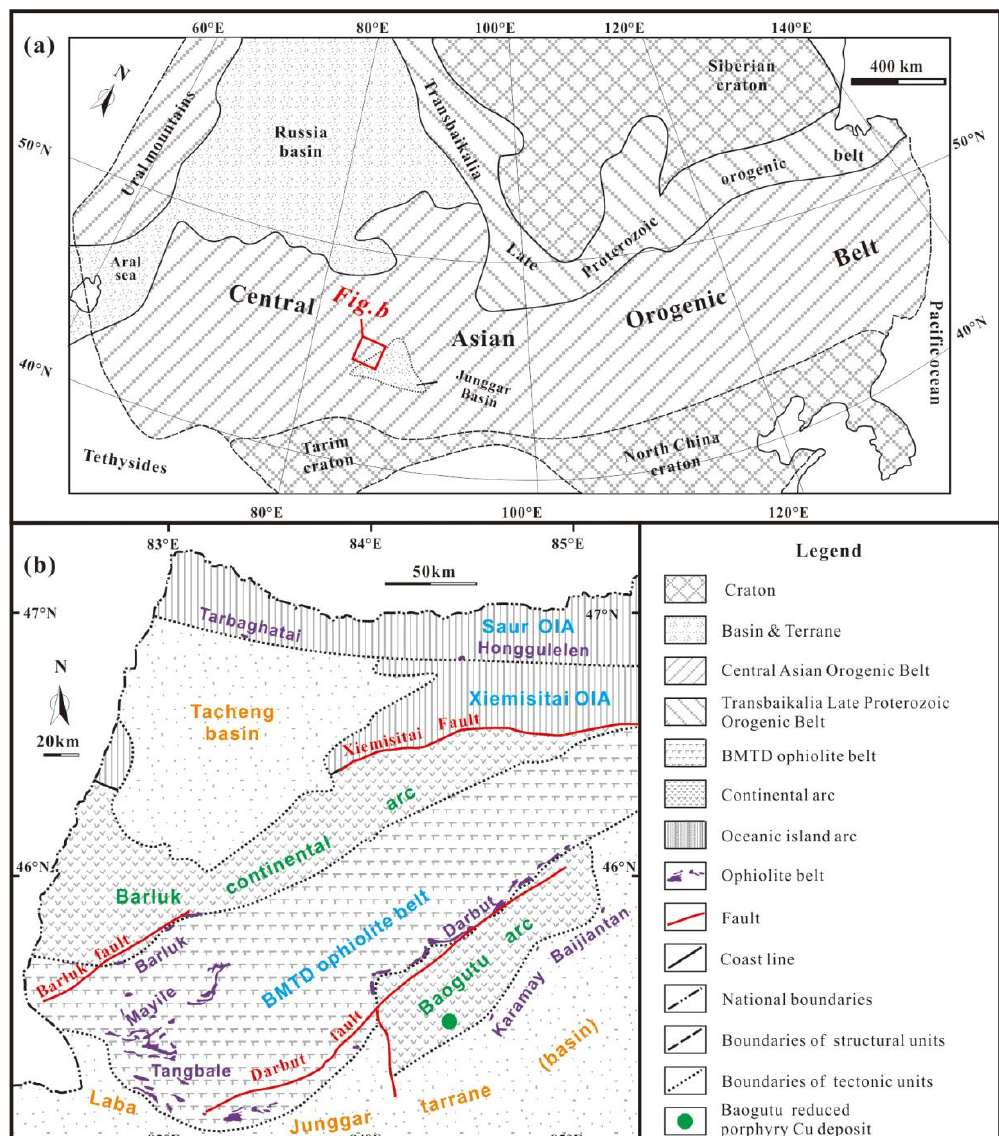
Figure 1. Location ( a ), (revised from [16,17]) and tectonic units ( b ), (revised from [19,20]) of the West Junggar, CAOB. Abbreviations: BMTD: Barluk–Mayile–Tangbale–Darbut; OIA: oceanic island arc.